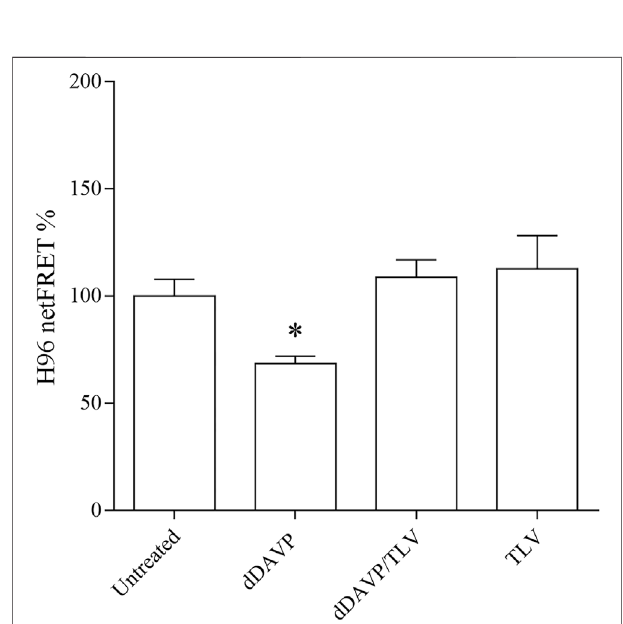
FIGURE 3 | Functional characterization of endogenous V2R receptor in HCT8 cells. cAMP levels were evaluated by FRET experiments in HCT8 cells transiently transfected with H96, as described in the Methods section. 5 min of stimulation with 100 nM dDAVP signi fi cantly reduced the netFRET signalsconsistentwithasigni fi cantincreaseinthecAMPlevelscomparedwith untreated cells. Data are expressed as means ± S.E.M. and analyzed by one- way ANOVA followed by Dunnett ’ s Multiple Comparison test (* p < 0.05 vs. untreated).